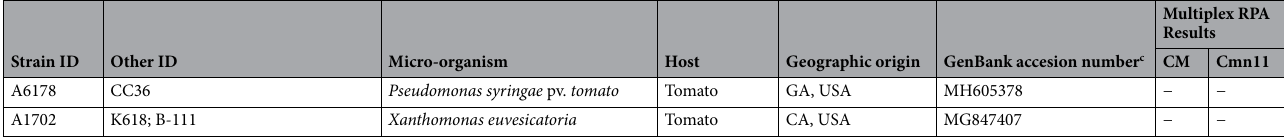
Table 1. Details of the bacterial strains used in inclusivity and exclusivity panels to validate the multiplex RPA assay for specific detection of genus Clavibacter in general and C. nebraskensis . + Indicated positive amplification. − Indicated negative amplification. a DNA extracted from infected corn tissues; no purified strain. b Strains used to infect corn/tomato plants. c Reference number (GenBank accession numbers) are adopted from Larrea-Sarmiento et al. 2019. Most of the strains included to validate this assays were also previously used by Larrea-Sarmiento et al. 2019. ATCC American Type Culture Collection, USA. CFBP Collection Française de Bactéries associées aux plantes (French Collection of Plant associated bacteria), LMG Collection of Laboratorium voor Microbiologie en Microbiele Genetica, Belgicum. *Sequences were not reported by Larrea-Sarmiento et al.. 2019.